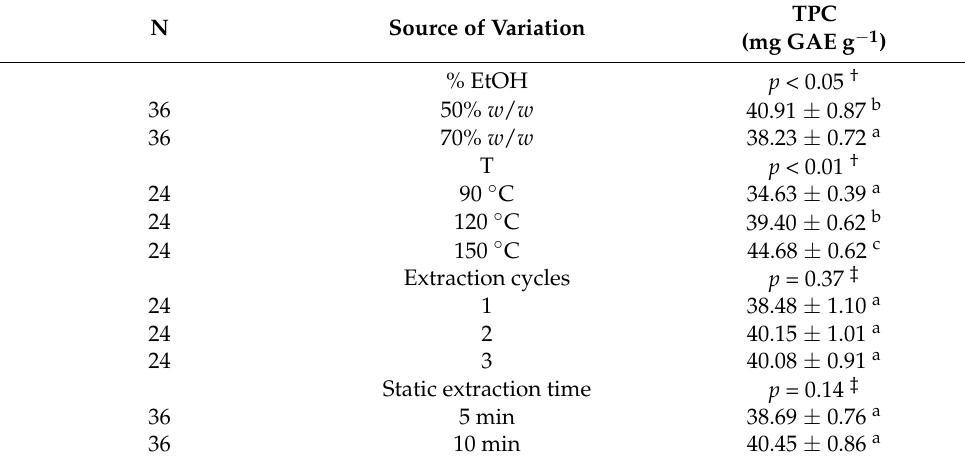
Table 2. Influence of different PLE parameters on total phenolic content of laurel leaf